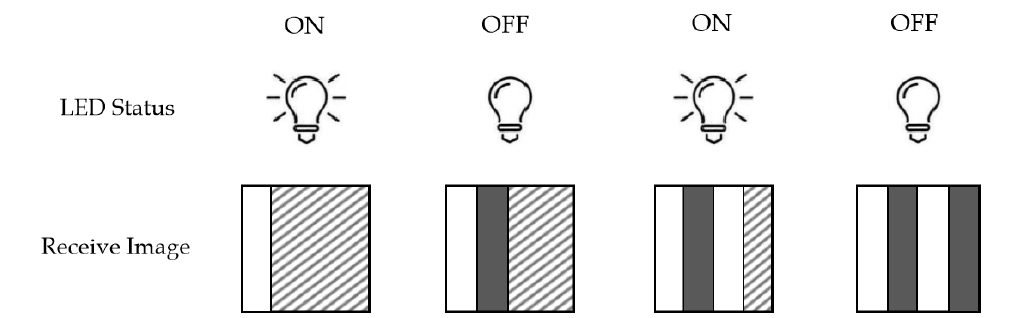
Figure 1. Schematic of the rolling shutter